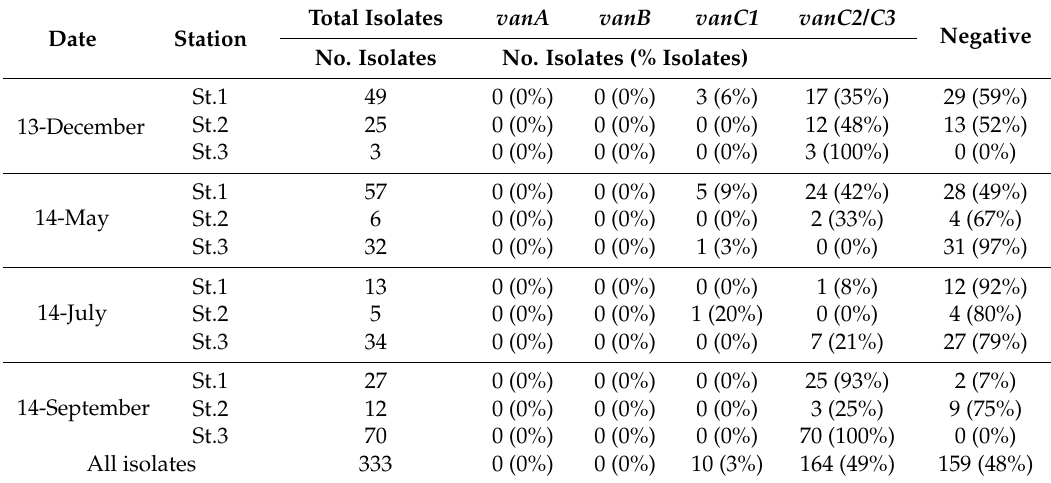
Table 4. Detection of vancomycin-resistant genes in enterococcal isolates in Yae